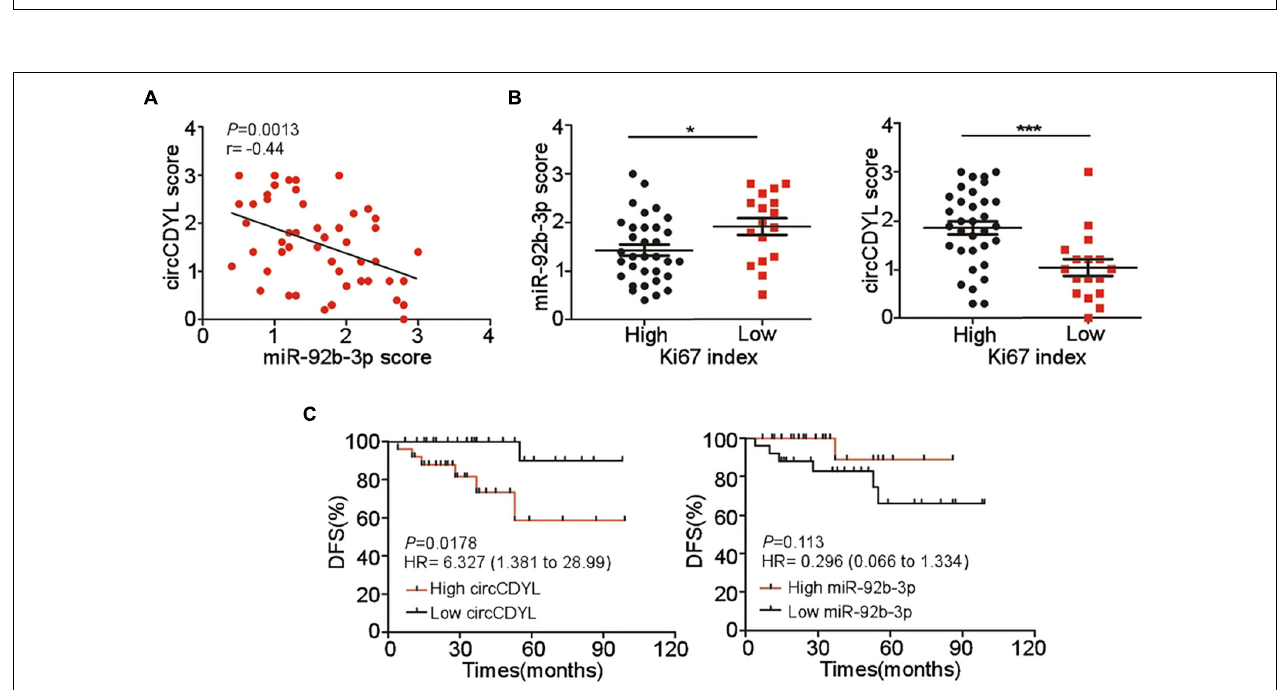
FIGURE 6 | Clinical significance of circCDYL and miR-92b-3p in HER2 + BC. (A) The correlations between the expression of circCDYL and miR-92b-3p, as detected by ISH in 50 HER2 + BC patient. (B) The expression of miR-92b-3p and circCDYL in HER2 + BC patients with high Ki67 index ( > 14%) and low Ki67 index ( < =14%). (C) Kaplan–Meier analysis of Disease-free survival of HER2 + BC patients ( n = 50) with high/low expression of circCDYL (left) or miR-92b-3p (right).